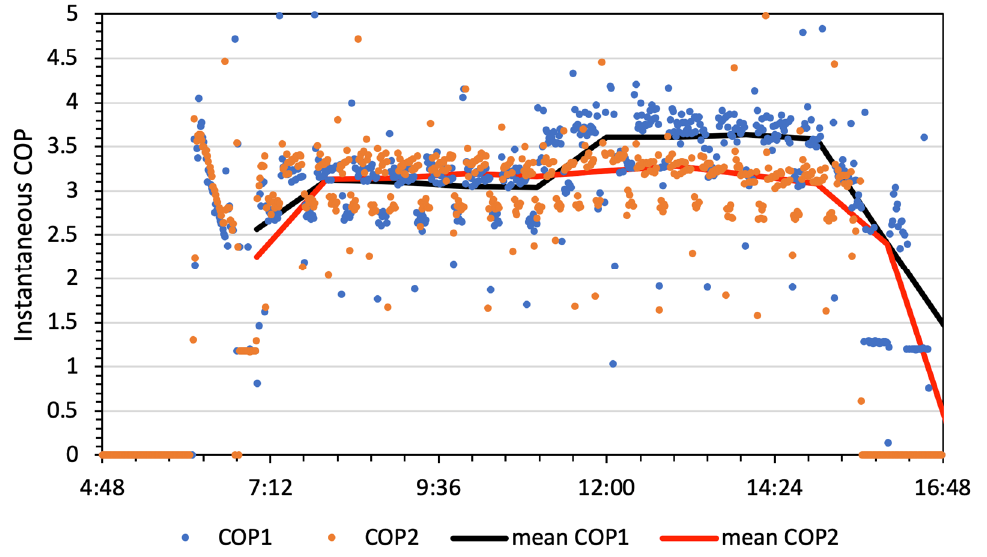
Figure 11. Instantaneous COP comparison between HVAC-1 and HVAC-2. Data acquired on 8 February 2021.